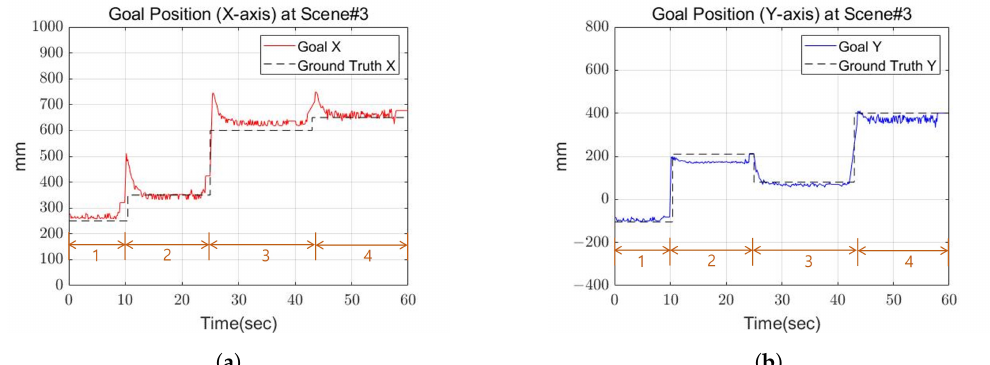
Figure 22. The goal position of Scene 3. ( a ) X-axis goal position at Scene 3; ( b ) Y-axis goal position at Scene 3.